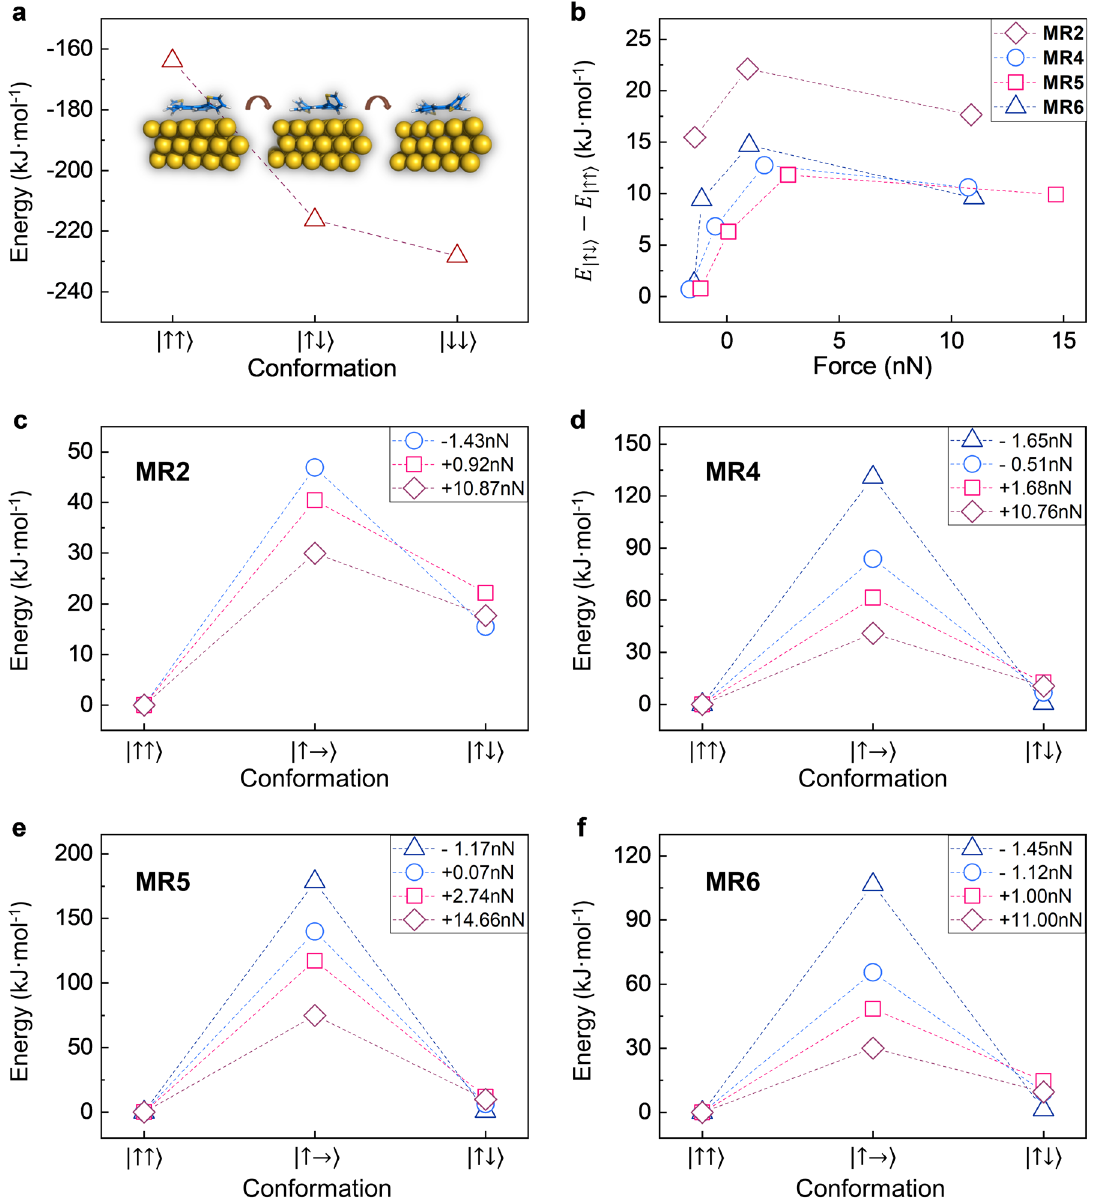
Fig. 3 Electronic energy difference of molecular rotor in polar and non-polar state. a Adsorption energy of three possible conformations of MR2 on Au(111). b Electronic energy difference between ""j i and "#j i , i.e., E "#ij (cid:2) E ""ij of MR2 , MR4 , MR5 and MR6 under directional mechanical force. c - f Electronic energy of molecular rotors in polar ( ""j i ), transition state( "!j i ), and non-polar ( "#j i ) states under different mechanical